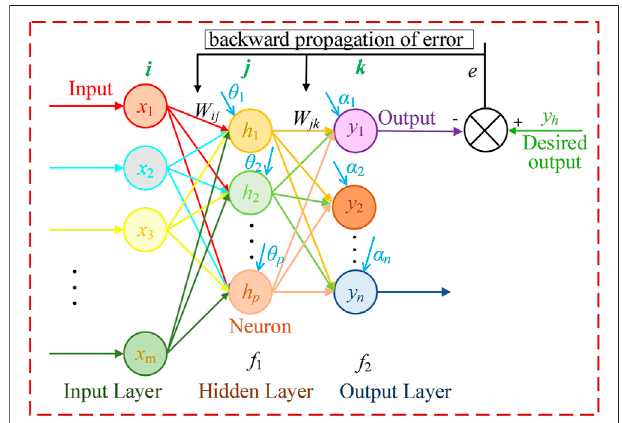
FIGURE 1 | Basic structure of the BP neural